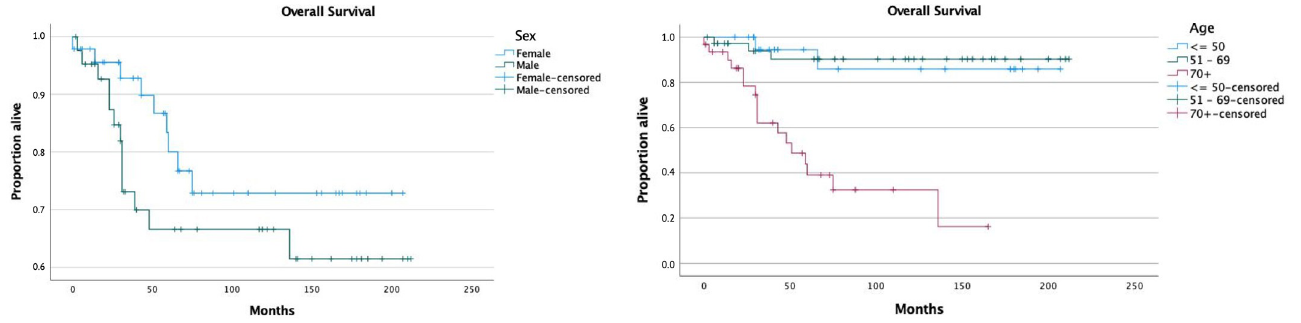
Figure 1. Survival distribution according to age and sex.